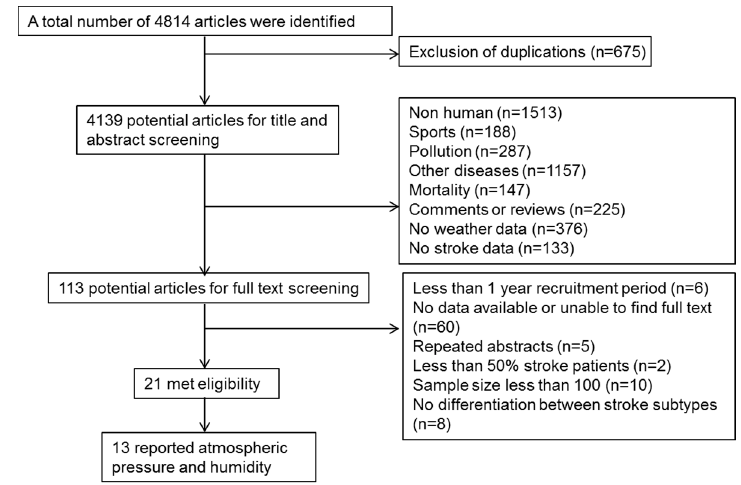
Figure 1. Flow chart of literature search.